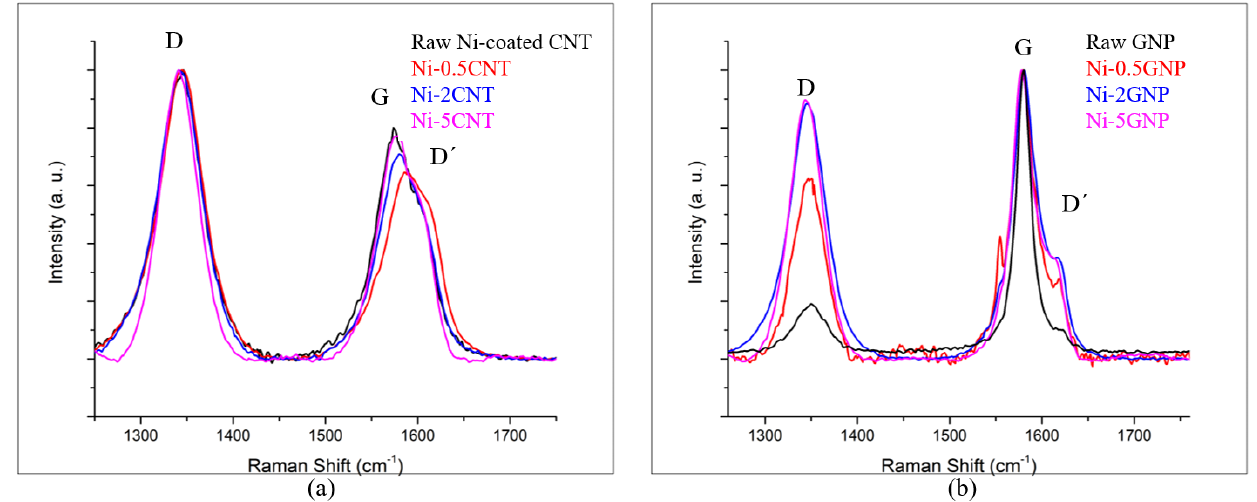
Figure 5. Raman spectra for ( a ) raw Ni-coated CNTs and Ni-CNT composites; ( b ) raw GNPs and Ni-GNP composites.